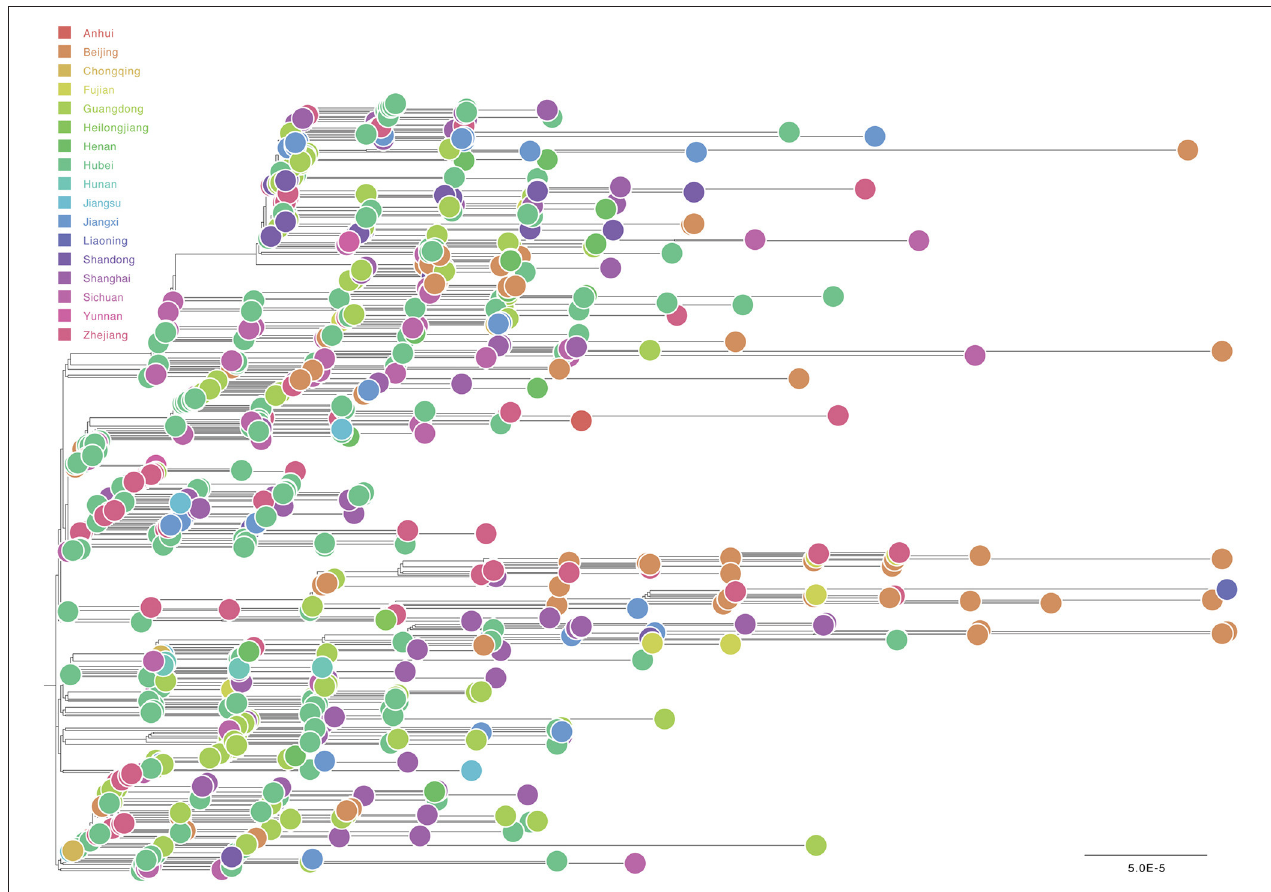
FIGURE 3 | Estimated maximum-likelihood phylogenetic tree of SARS-CoV-2 from Mainland China. Maximum-likelihood phylogenetic tree of SARS-CoV-2 for “dataset_729” from Mainland China is shown. Tree is midpoint rooted. Colors indicate different sampling provinces from Mainland China. The scale bar at the bottom indicates 0.00005 nucleotide substitutions per